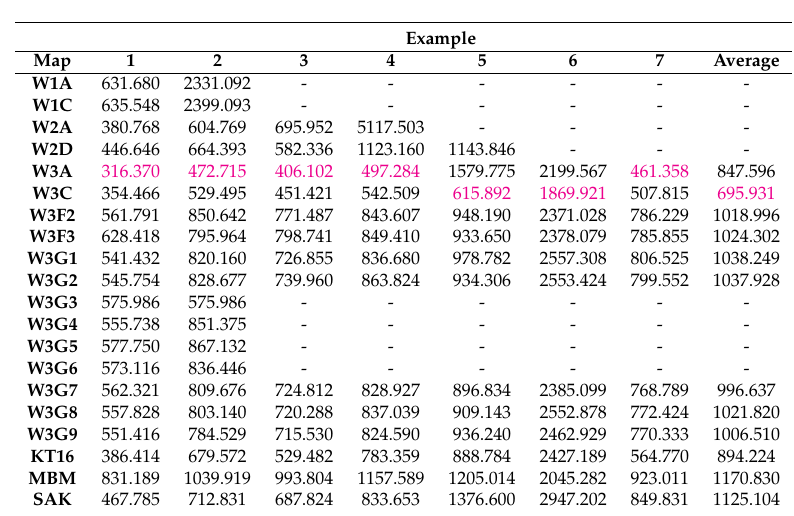
Table 6. CPU time (in seconds) required for each example(1–7) using a Dell Multiplex-990.